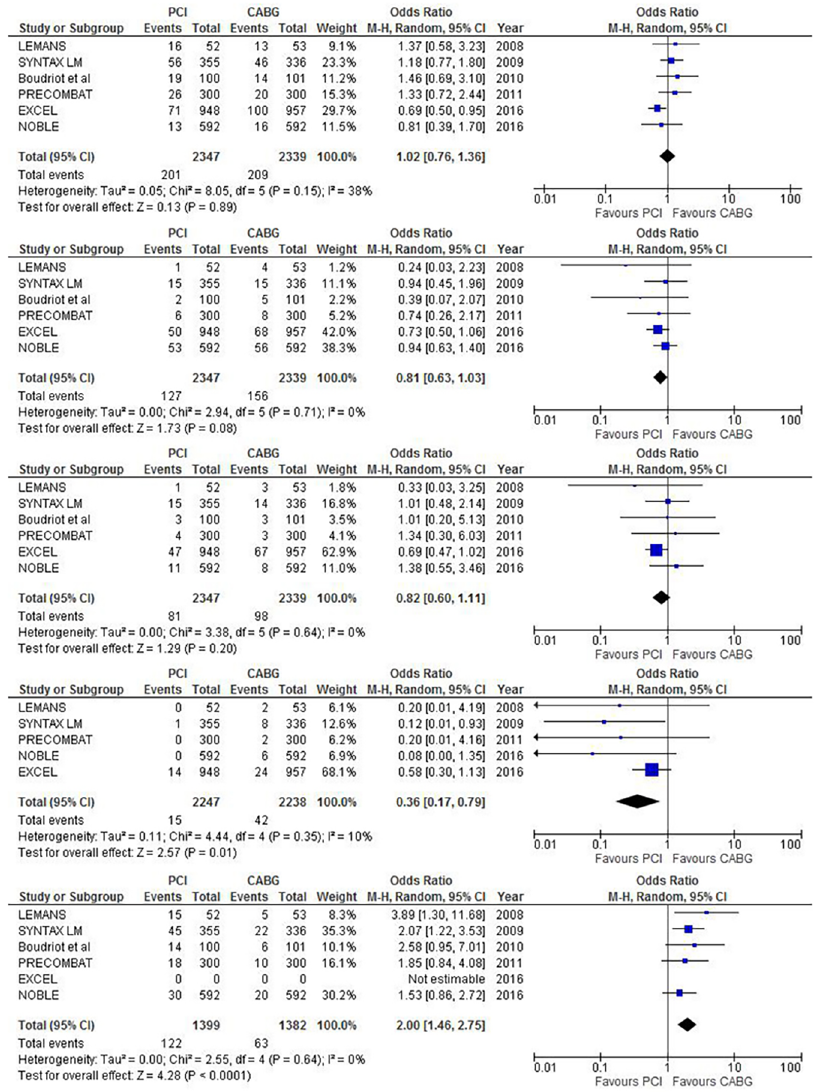
Fig 2. Major adverse cardiovascularevents at 1 year (from top to bottom, MACE, Death, MI, Stroke, TVR).